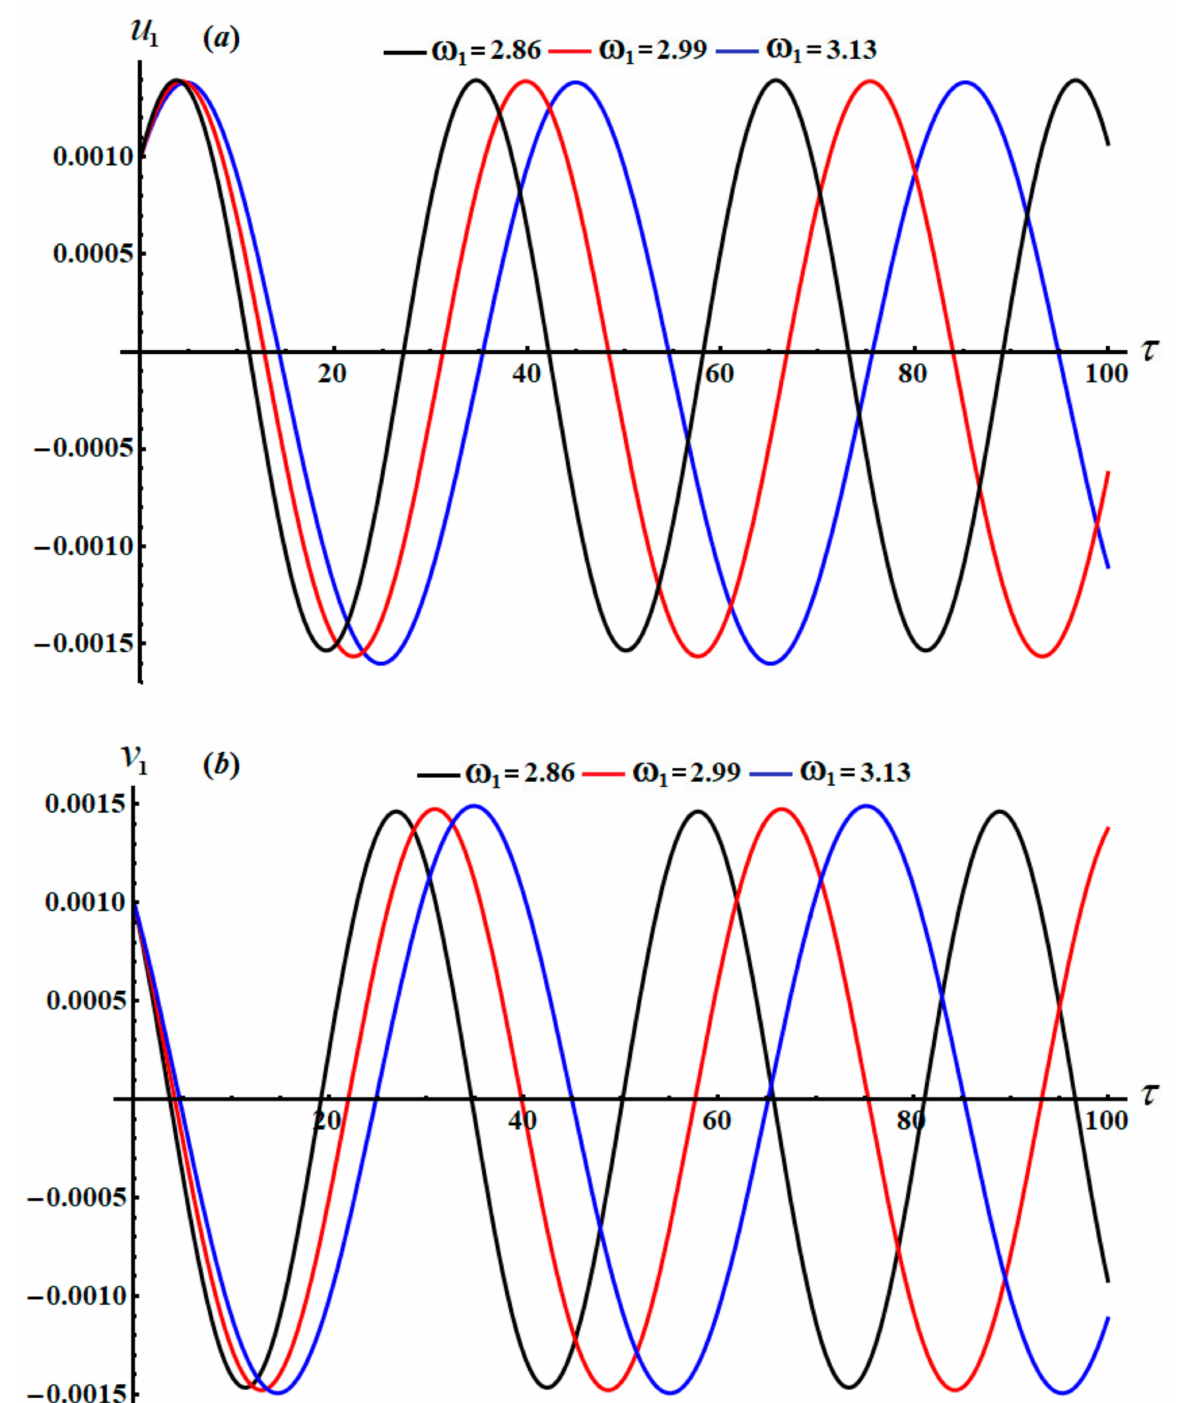
Figure 12. Description of the modified amplitudes via τ when ω 1 = ( 2.86,2.99,3.13 ) : ( a ) u 1 , ( b ) v 1